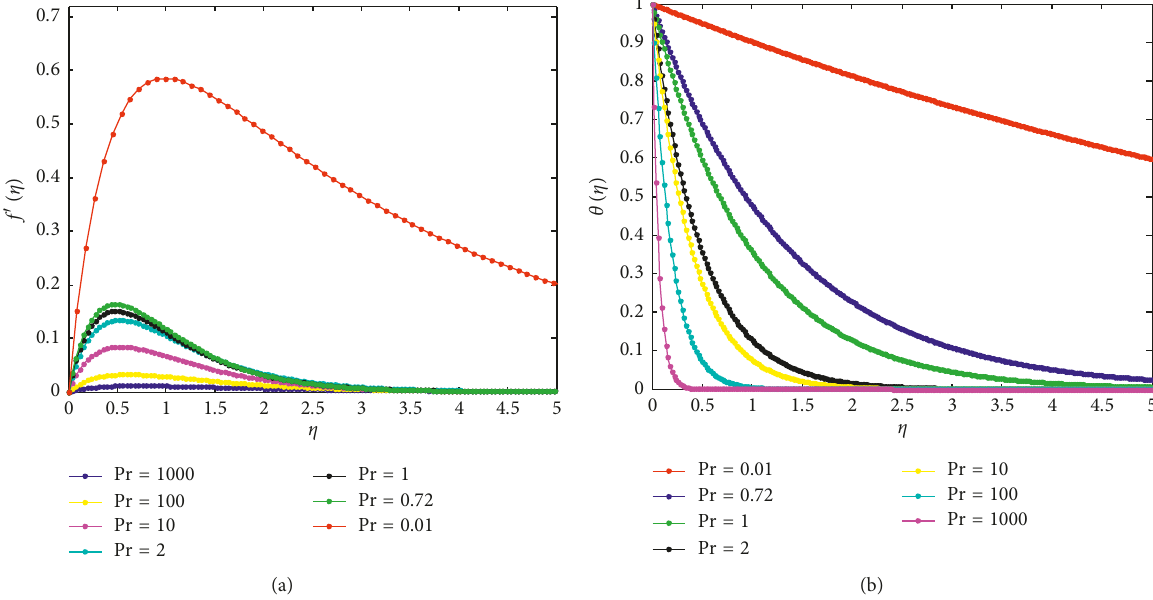
Figure 11: (a) Effects of Prandtl number on the velocity profile for spherical-shaped nanoparticle. (b) Effects of Prandtl number on the temperature profile for spherical-shaped